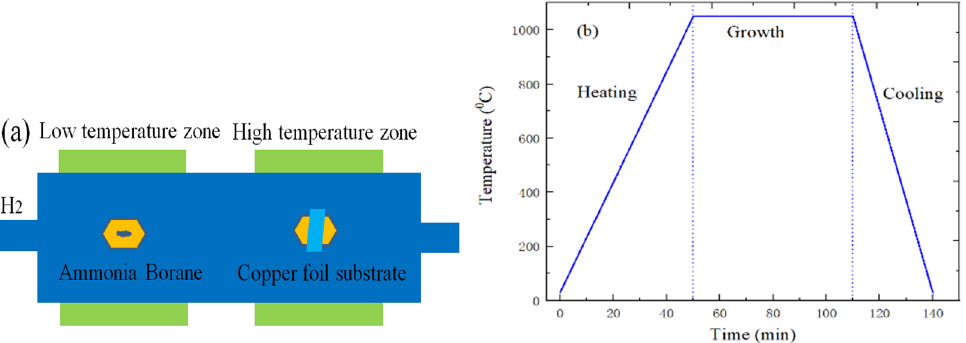
Figure 13. ( a ) the growth schematic diagram of h-BN; ( b ) CVD growth temperature change curve of h-BN.